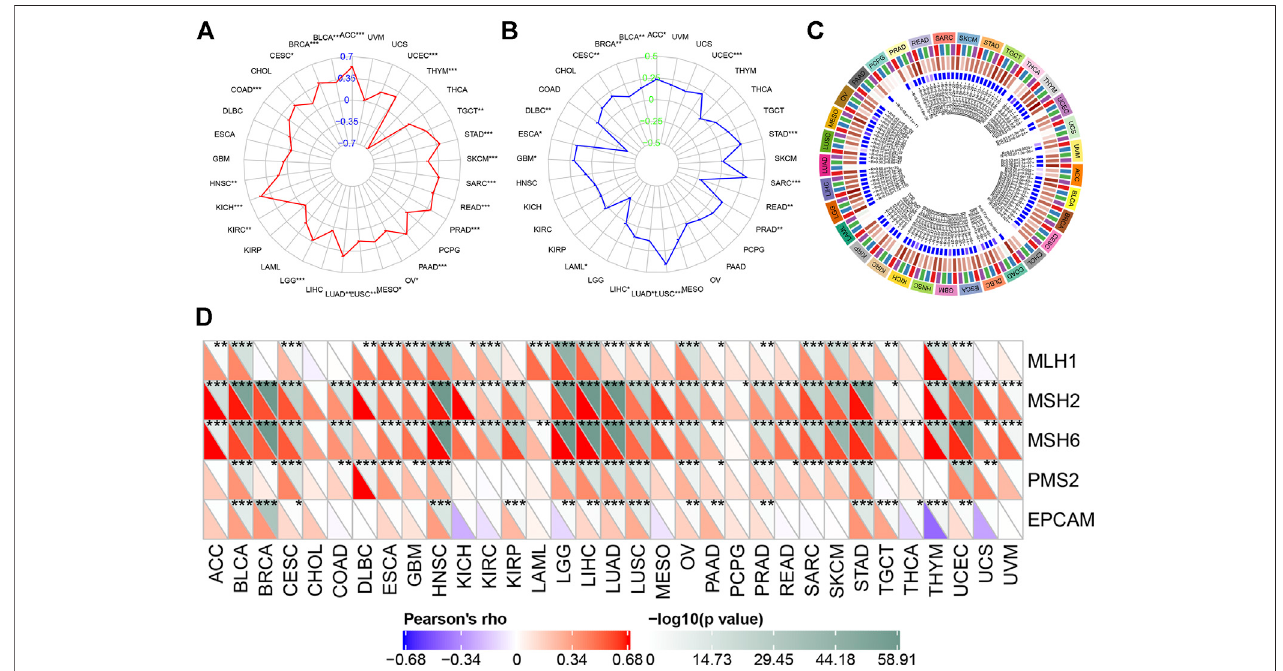
FIGURE5| ThecorrelationsbetweenKIF18Bexpressionandtumormutationburden(TMB),microsatelliteinstability(MSI),DNAmethylation,andmismatchrepairs (MMRs)invariouscancers. (A) ThecorrelationsbetweenKIF18BexpressionandTMBin33typesofcancers. (B) ThecorrelationbetweenKIF18BandMSIin33typesof cancers. (C) The correlations between KIF18B and four methyltransferases (DNMT1: red, DNMT2: blue, DNMT3A: green, and DNMT3B: purple) in 33 types ofcancers. (D) The correlation between KIF18B and fi ve MMRs related genes in 33 types of